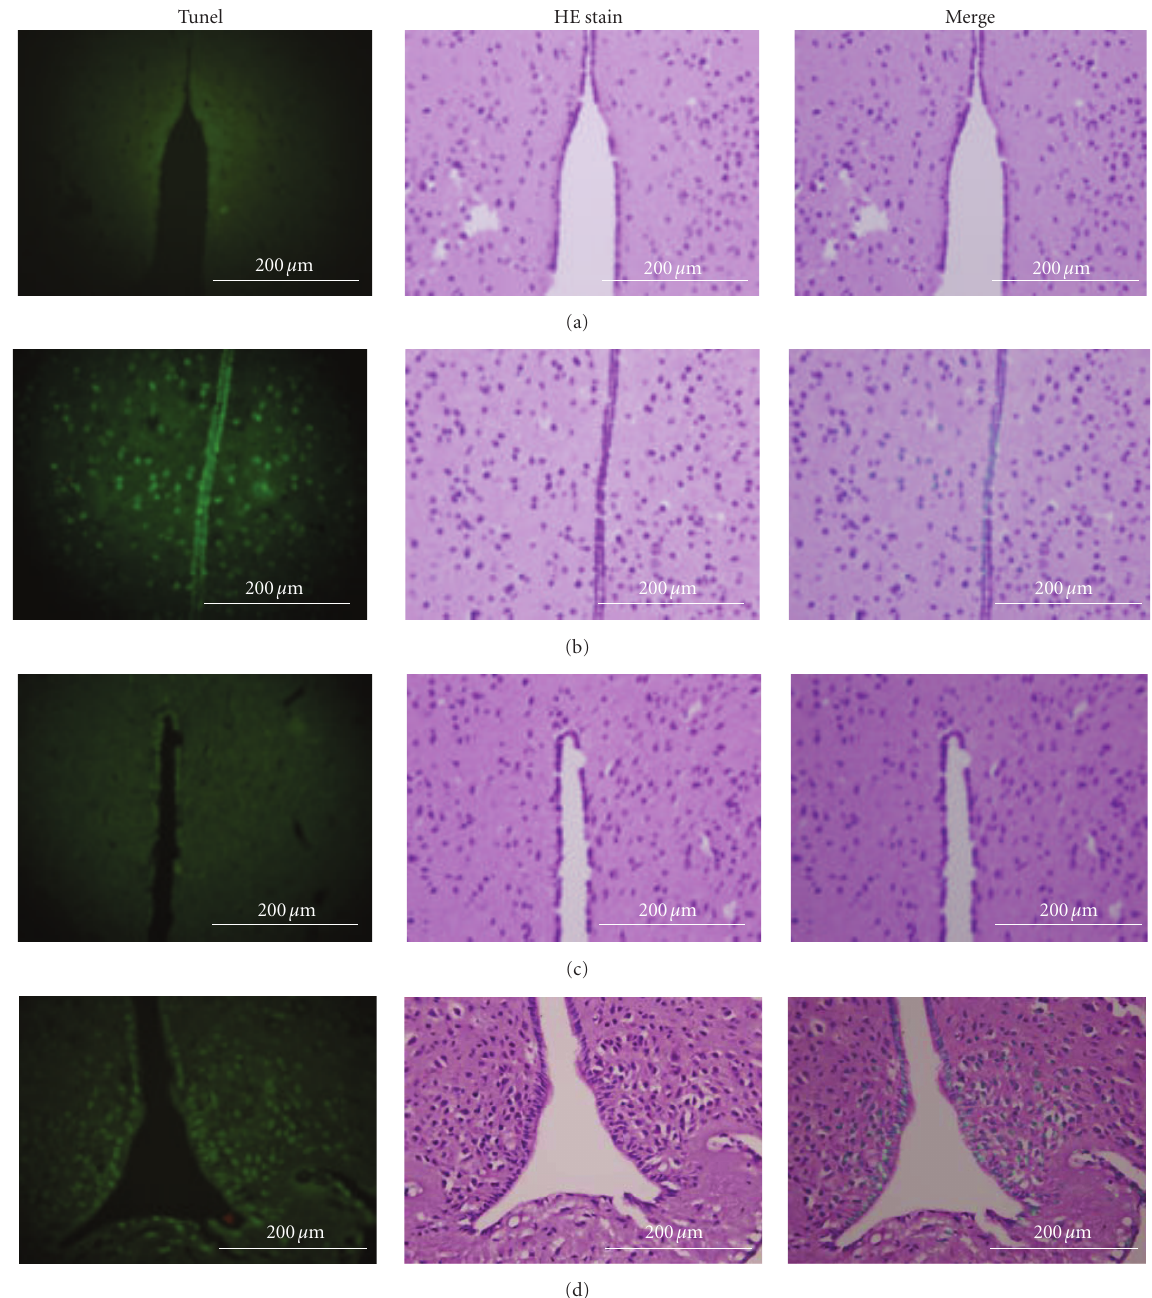
Figure 5: Photomicrographs of TUNEL, HE, and merged (TUNEL+HE) staining of the hypothalamus of an NC mouse (a), a SOH mouse (b), a CVH mouse (c), and a CTH mouse (d). Apoptosis (green fluorescence; TUNEL staining) broadly colocalized with HE staining (purple color) of neurons to yield the blue color. Apoptosis is associated with pyknosis of the nucleus (b and d) ×